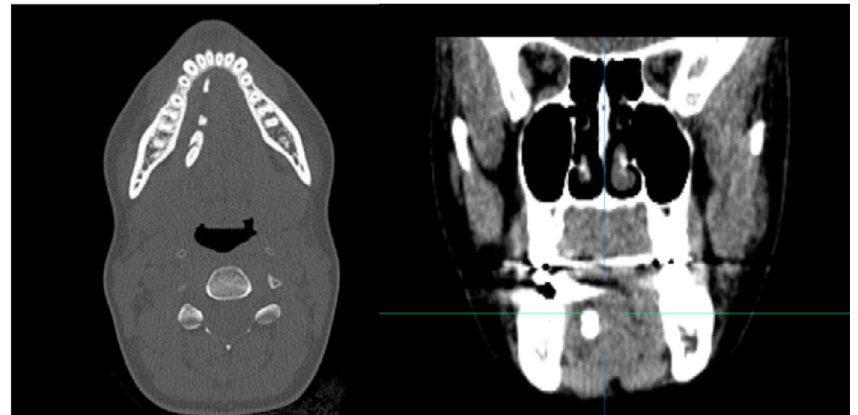
Fig. 9. Example of a computed tomography showing a left submandibular salivary stone.